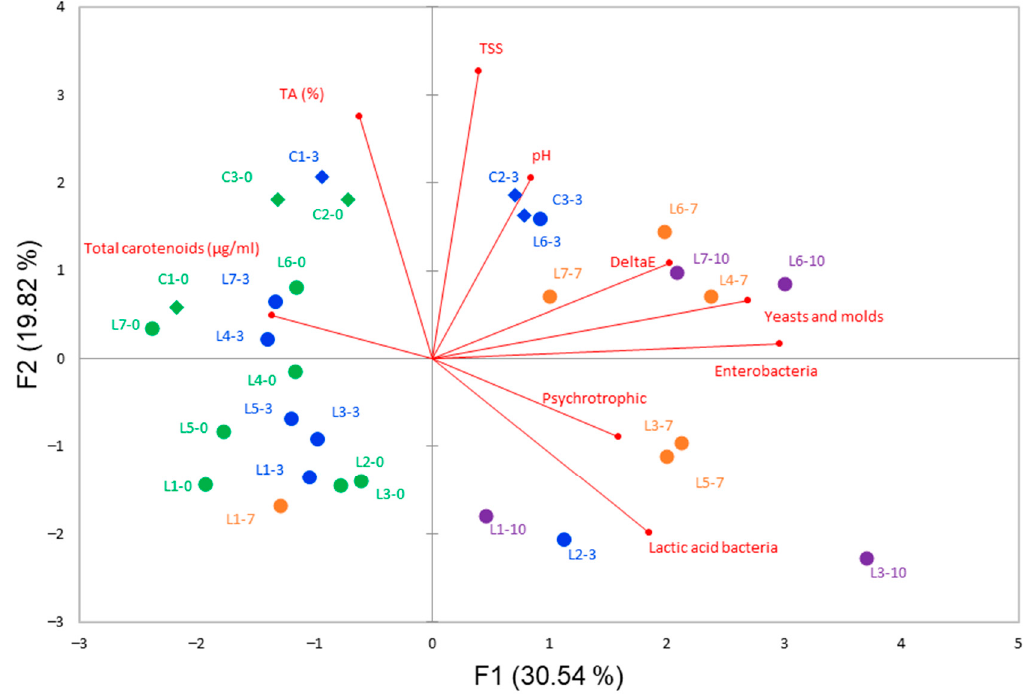
Figure 2. Principal component analysis of physicochemical and microbiological data collected from carrot juice of the batches L1 to L7 and C1 to C3 during refrigerated storage, after 0, 3, 7, and 10 days. Each vector in red corresponds to variables, and dots to samples. Samples were labelled as batch number-day of analysis.